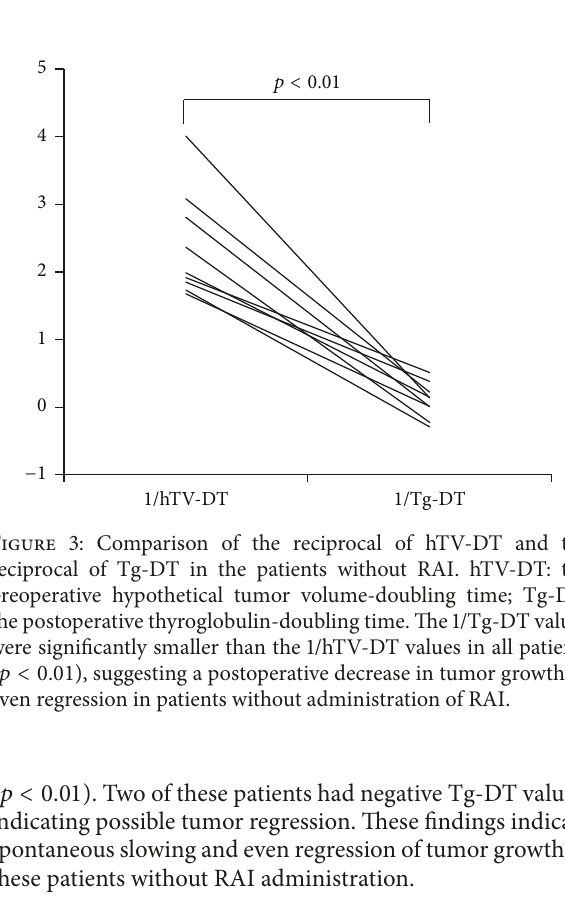
Figure 2: Comparison of the reciprocal of hTV-DT and the reciprocal of Tg-DT. hTV-DT: the preoperative hypothetical tumor volume-doubling time; Tg-DT: the postoperative thyroglobulin- doubling time. The 1/Tg-DT values were significantly smaller than the 1/hTV-DT values in all patients ( 𝑝 < 0.001 ), suggesting a postoperative decrease in tumor growth or even regression.